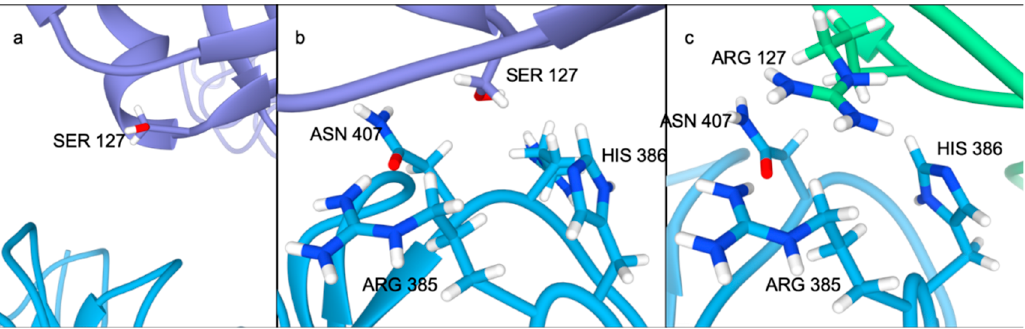
Figure 3. Interface surrounding residue 127 in the ( a ) wild-type, ( b ) Arg496Trp, and ( c ) Ser127Arg systems at the end of 500 nanoseconds of simulation.